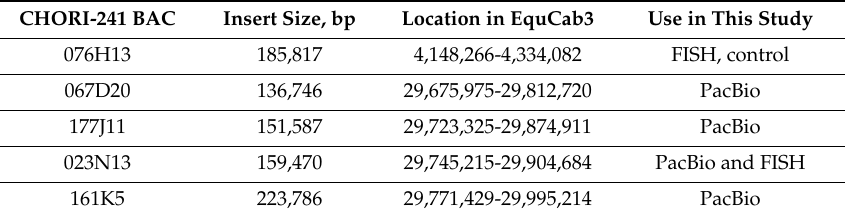
Table 1. Information about ECA29 bacterial artificial chromosome (BAC) clones used for sequencing and fluorescence in situ hybridization (FISH)